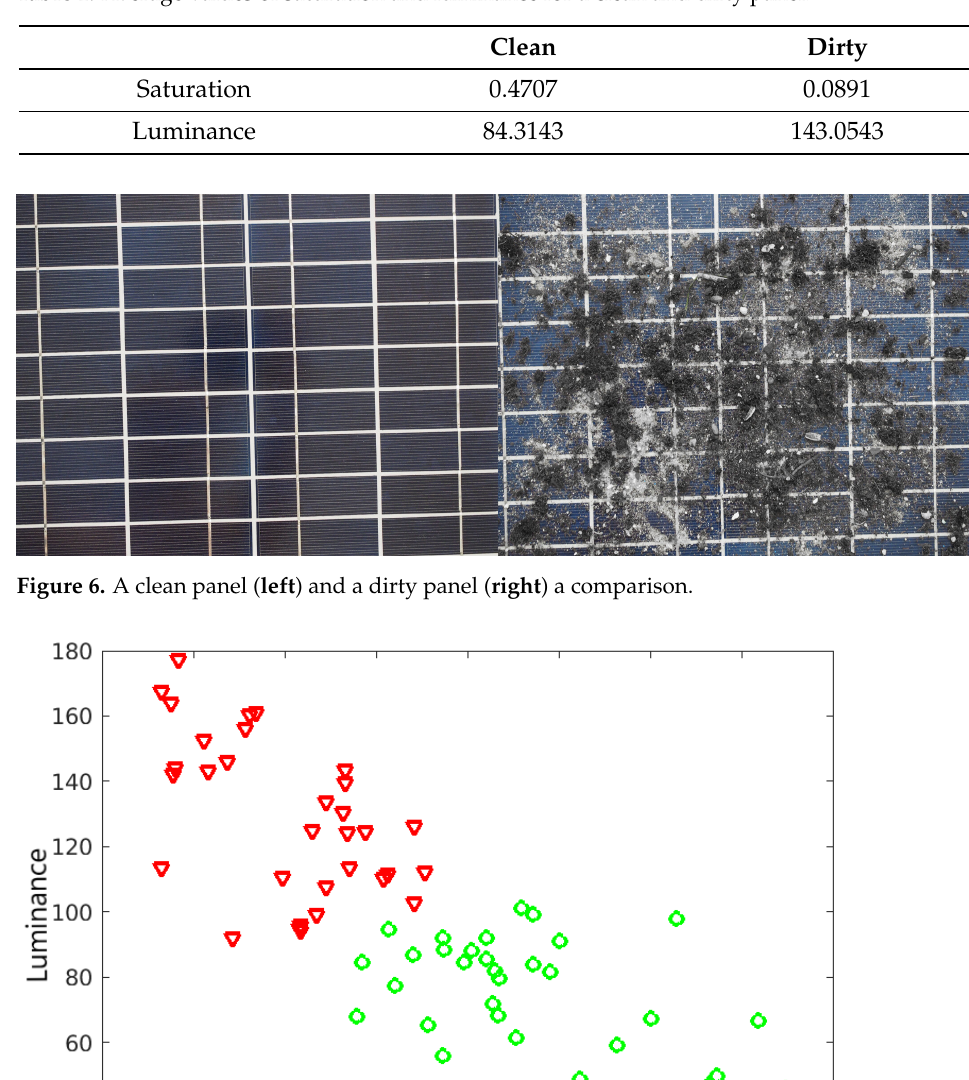
Table 1. Average values of saturation and luminance for a clean and dirty panel.